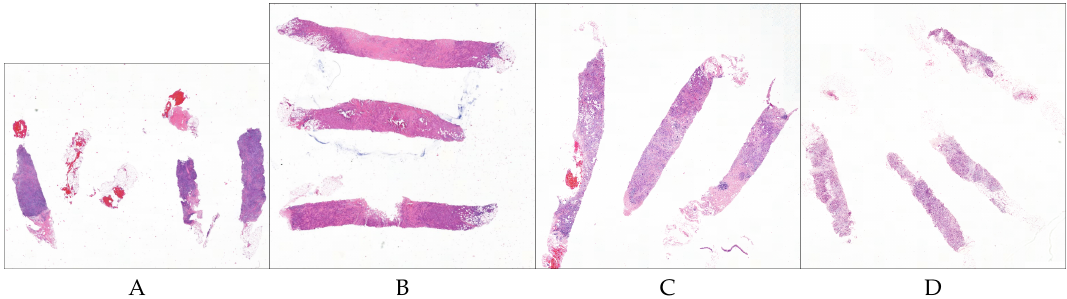
Figure 1. Example of tiles from the HEROHE dataset. The left-most two slides ( A , B ) have been labelled as positive for HER2; The right-most two slides ( C , D ) have been labelled as